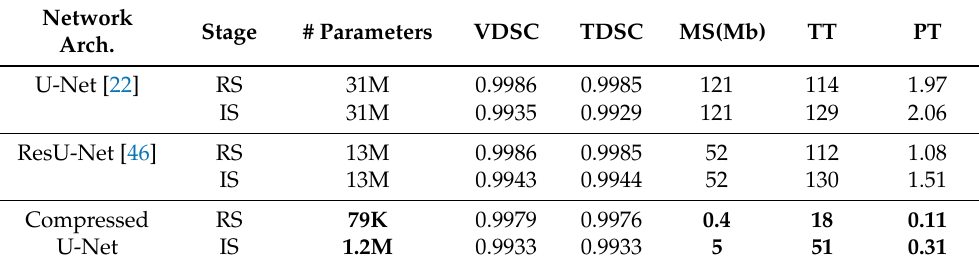
Table 3. A comparison between the original U-Net and the compressed U-Net (proposed). The prediction time (in seconds) is observed on CPU only for a single B-scan. Abbreviations: VDSC— entries corresponding to the proposed network are highlighted in